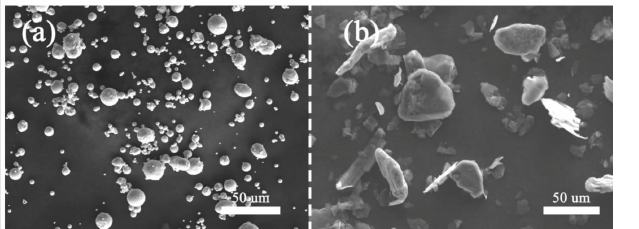
Figure 1. SEM images of ( a ) novel nitrogen-free austenitic stainless steel powder and ( b ) graphite